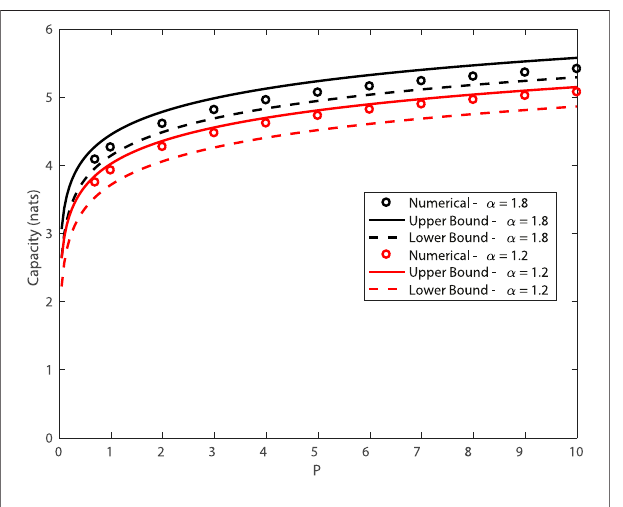
FIGURE 1 | Capacity of symmetric α -stable noise channels subject to a power constraint P , with c N (cid:3) 0.01.